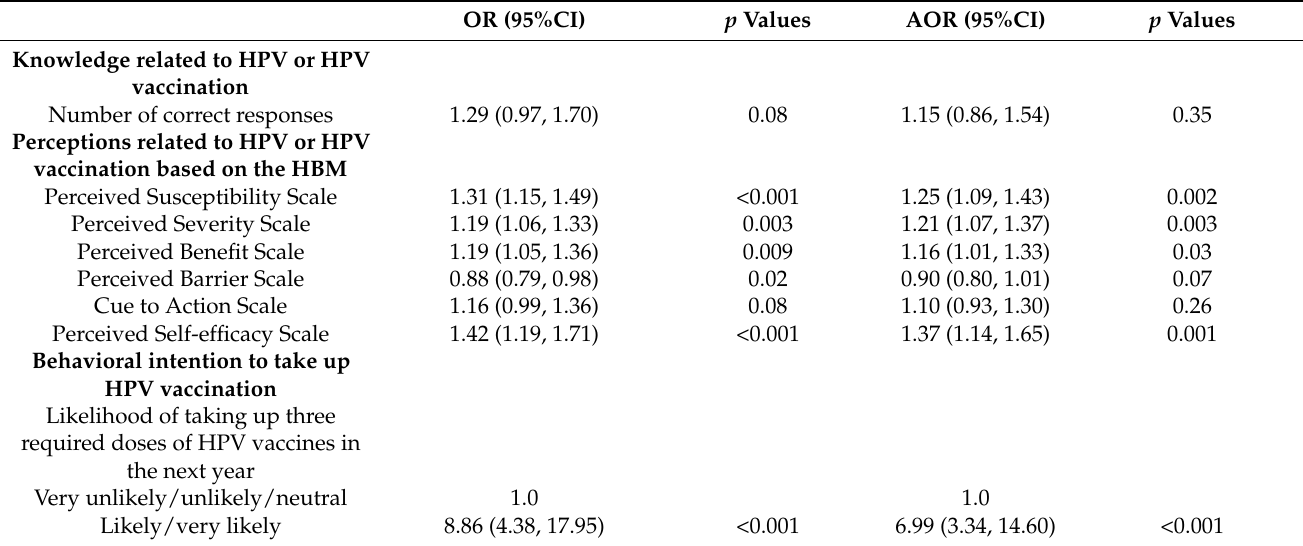
Table 3. Factors predicting human papillomavirus vaccination uptake (among participants who completed Month 12 follow-up, n =